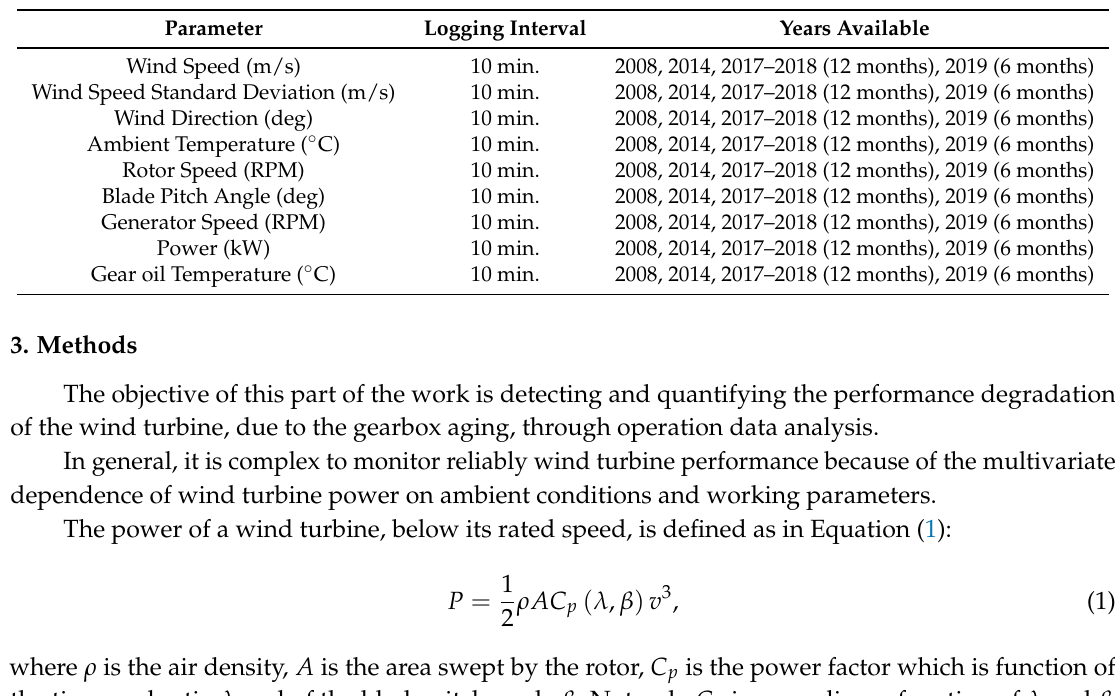
Table 2. SCADA parameters